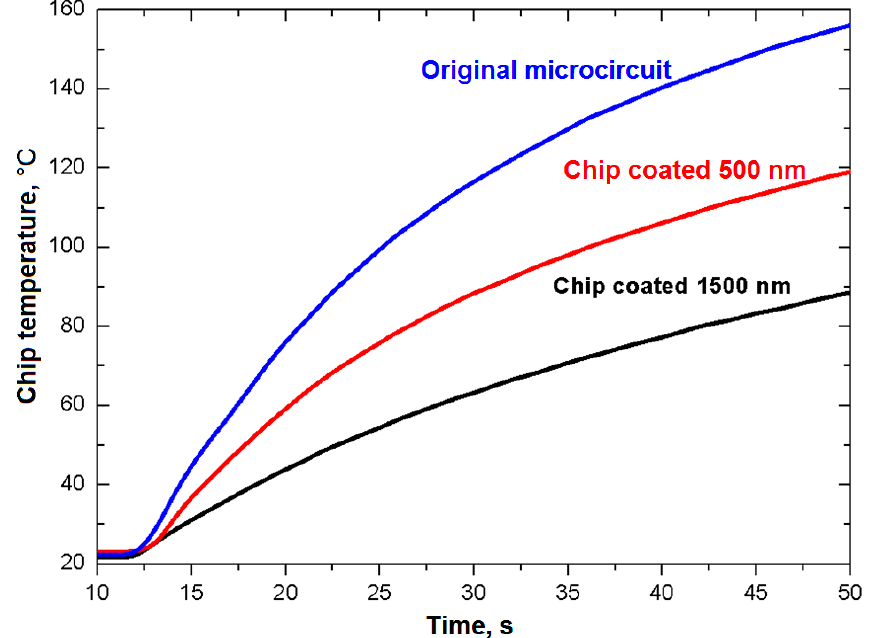
Figure 7. The temperature growth rate depending on the chip coating thickness.